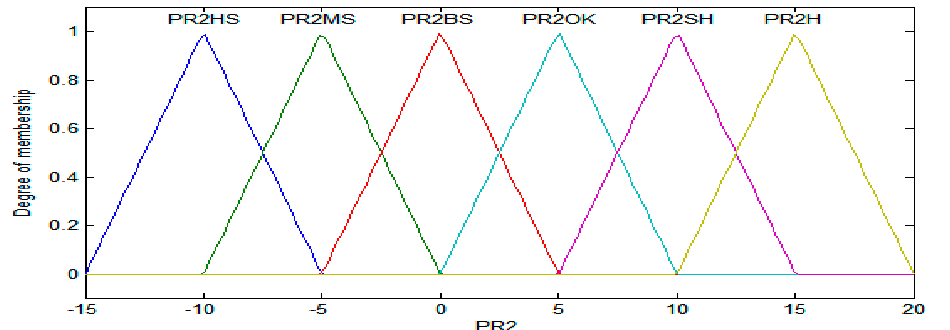
Figure 9. Illumination fuzzy controller outputs.